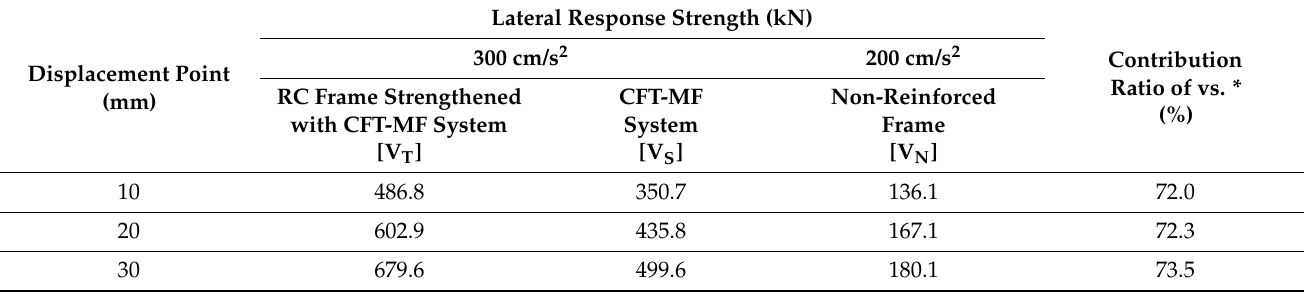
Table 8. Contribution of each member’s load to seismic response displacement determined based on Figure 25. Lateral Response Strength (kN) Displacement Point (mm)